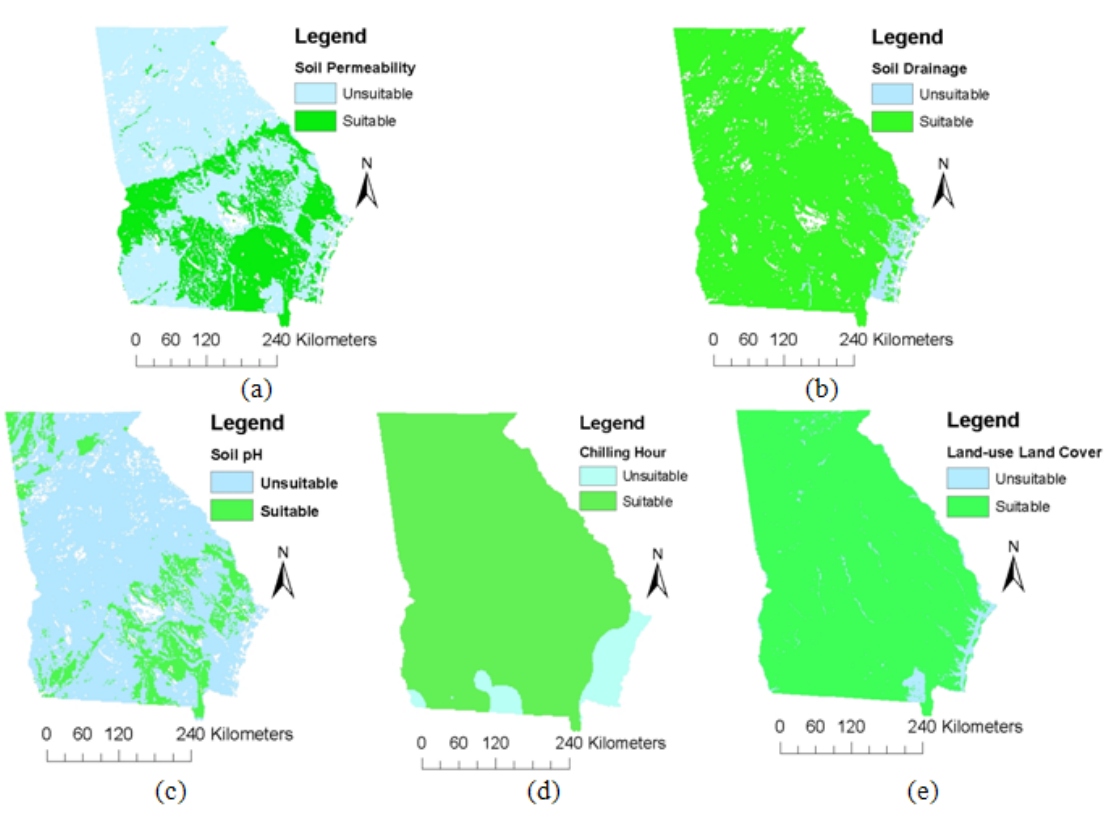
Figure 8. Blueberry production suitability map for